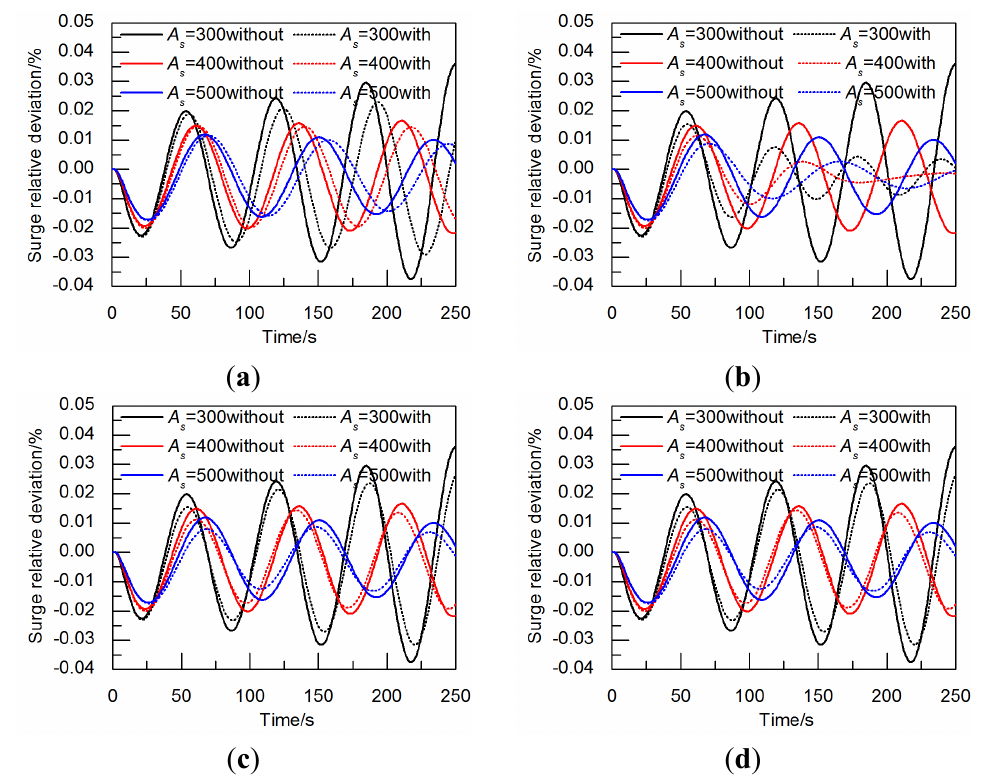
Figure 12. The influence of considering an open channel or not on the regulation